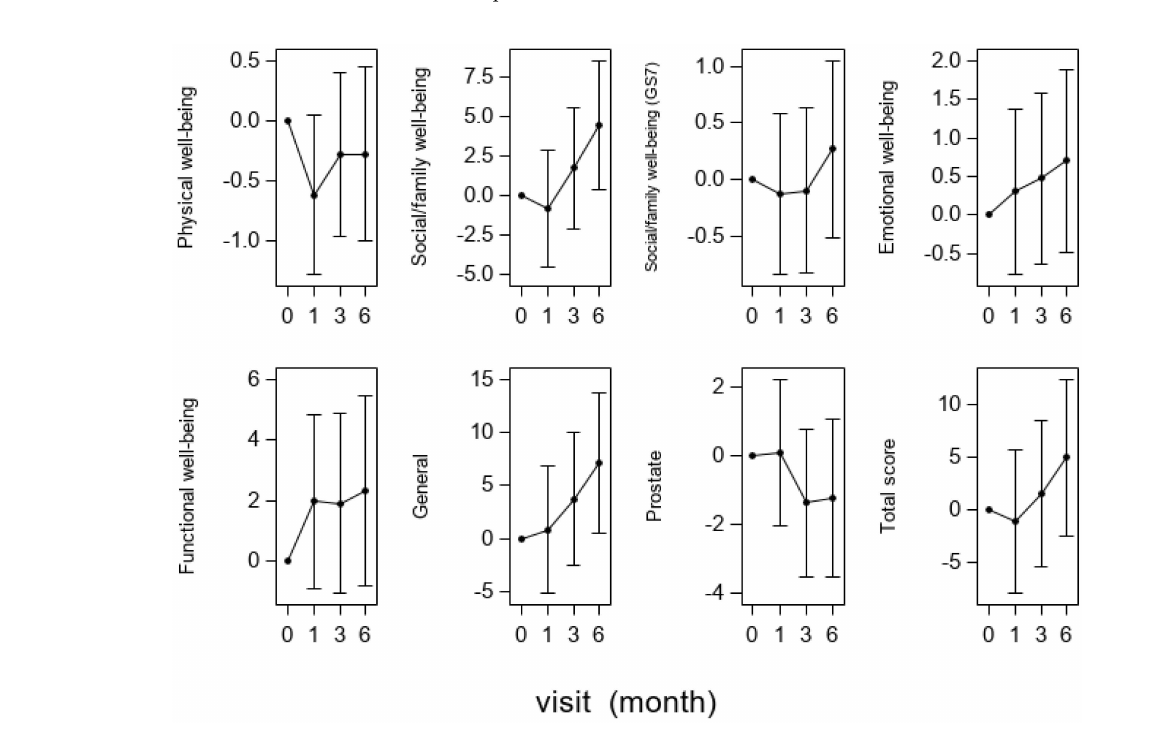
Figure 3. Least-squares mean differences between the baseline and time points for each domain in